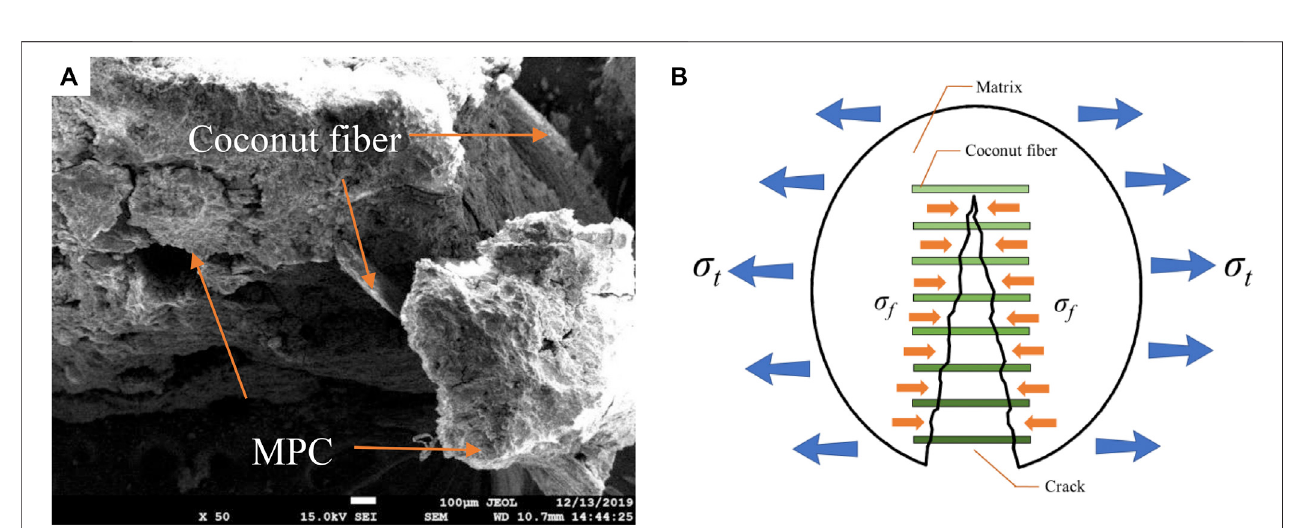
FIGURE 8 | Bridge effect of CF (A) connection of CF to MPC; (B) schematic.